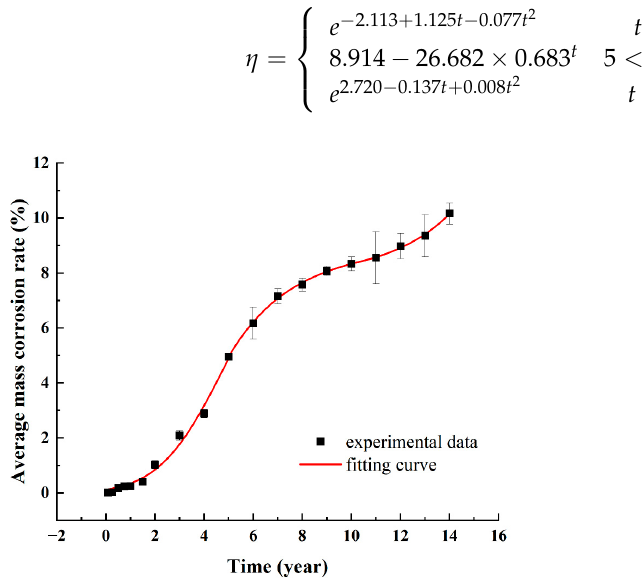
Figure 1. Variation curve of average mass corrosion ratio with time.